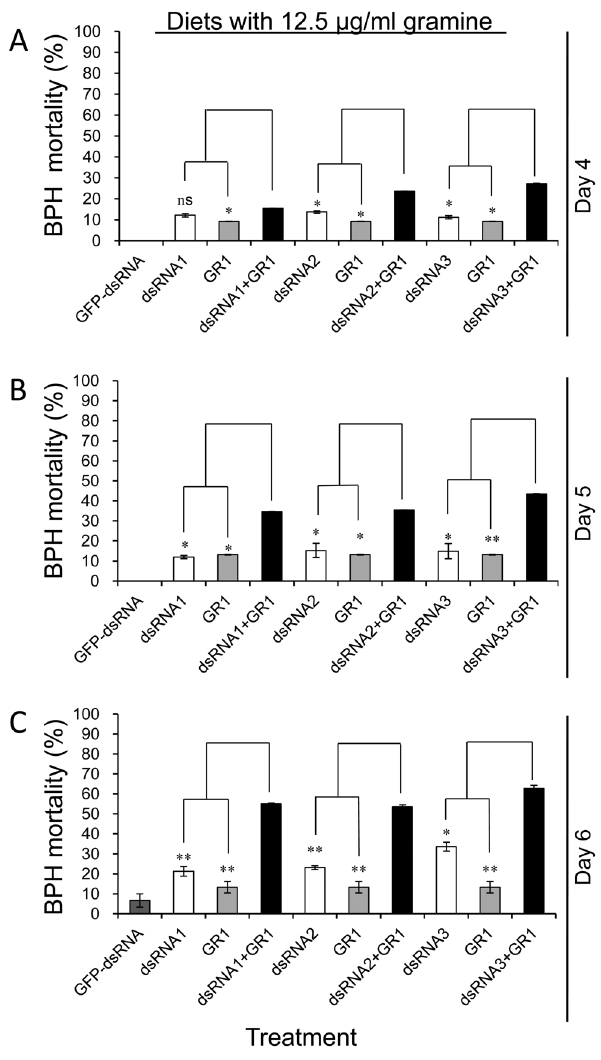
Figure 5. Sensitivity of nlgst1-1 dsRNA pre-fed BPHs to the diets containing gramine. Gramine was dissolved in artificial diets at the indicated concentrations (GR1=12.5 m g/ml). BHPs that had been pre- fed on diets containing 0 (0.8 m g/ml GFP -dsRNA, used as control), 0.2 (dsRNA1), 0.4 (dsRNA2) and 0.8 (dsRNA3) m g/ml nlgst1-1 dsRNA for 3 day were transferred to new diets with the indicated concentrations of gramine and to the normal control diet without dsRNA and gramine. The dsRNA pre-fed BPHs were continually reared on these new diets for an additional 3 days in the controlled growth chambers (90% r.h., 28 u C, 14 hr photoperiod). The mortalities of the dsRNA pre-fed BPHs transferred to the new diets were plotted at day 4 ( A ), day 5 ( B ) and day 6 ( C ) post feeding. Data represent the means 6 SD from three independent experiments with triplicate groups examined for each treatment in each experiment. *and **indicate significance at P , 0.05 and P , 0.01, respectively. ‘‘ns’’ indicates not significant ( P . 0.05).